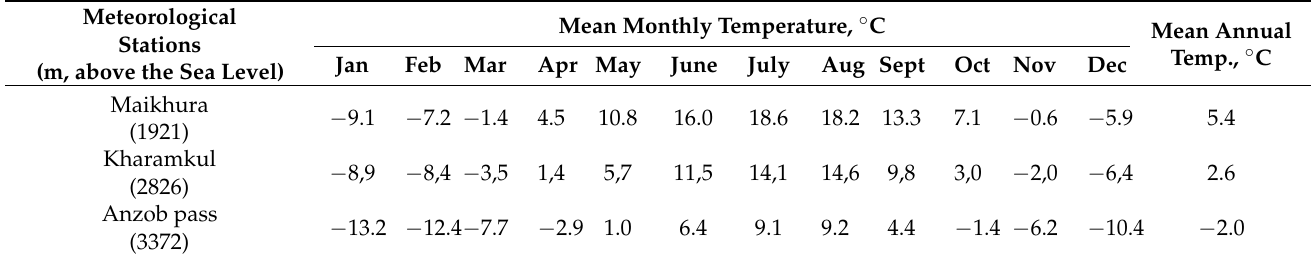
Table 2. Distribution of the mean monthly temperature in the study